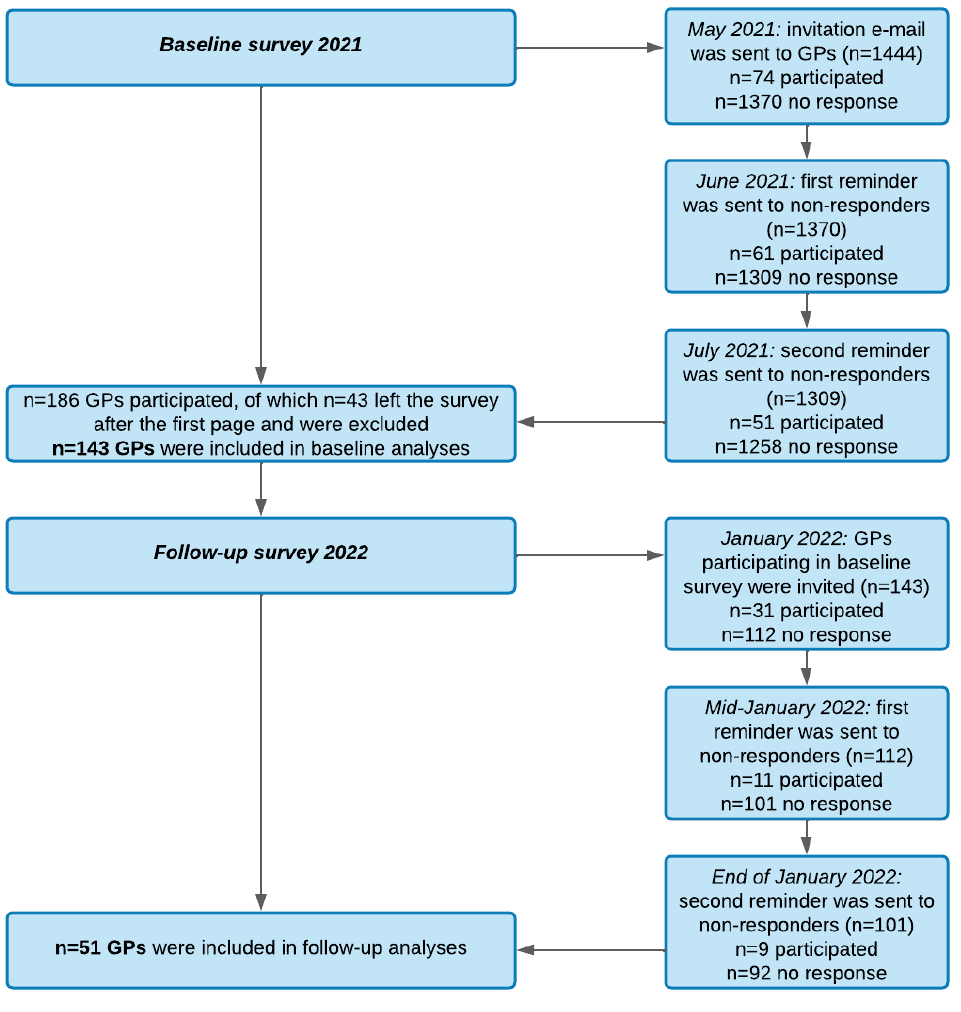
Figure 1. Flowchart of recruitment process.